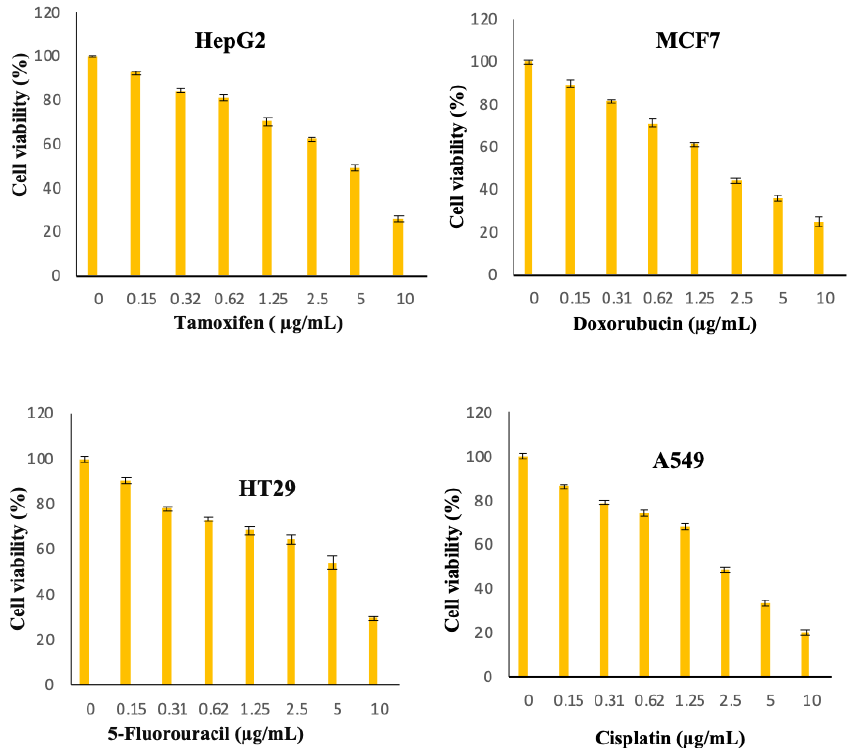
Figure 13. Chemotherapeutic effects on the viability of treated cells (MCF7, HepG2, A549, and HT29) using MTT assay after 72h. Table 3. IC 50 of Tamoxifen, Doxorubicin, 5-Fluorouracil and Cisplatin on HepG2, MCF7, A549 and HT29 after 24, 48 and 72h of incubation.